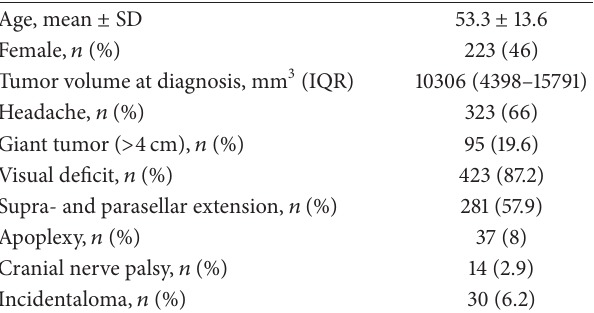
Table 1: Baseline characteristics of the patients with NFPA ( 𝑛 = 485